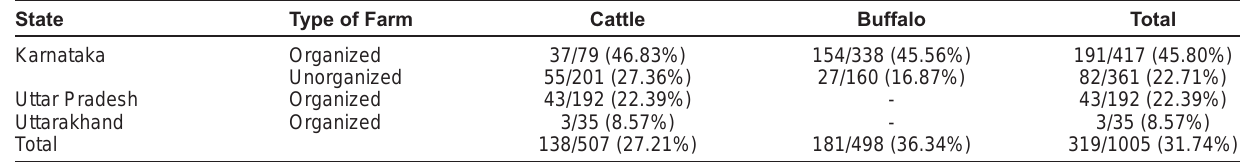
Table-1. Prevalence of brucellosis in cattle and buffaloes of three different states of India, assayed using